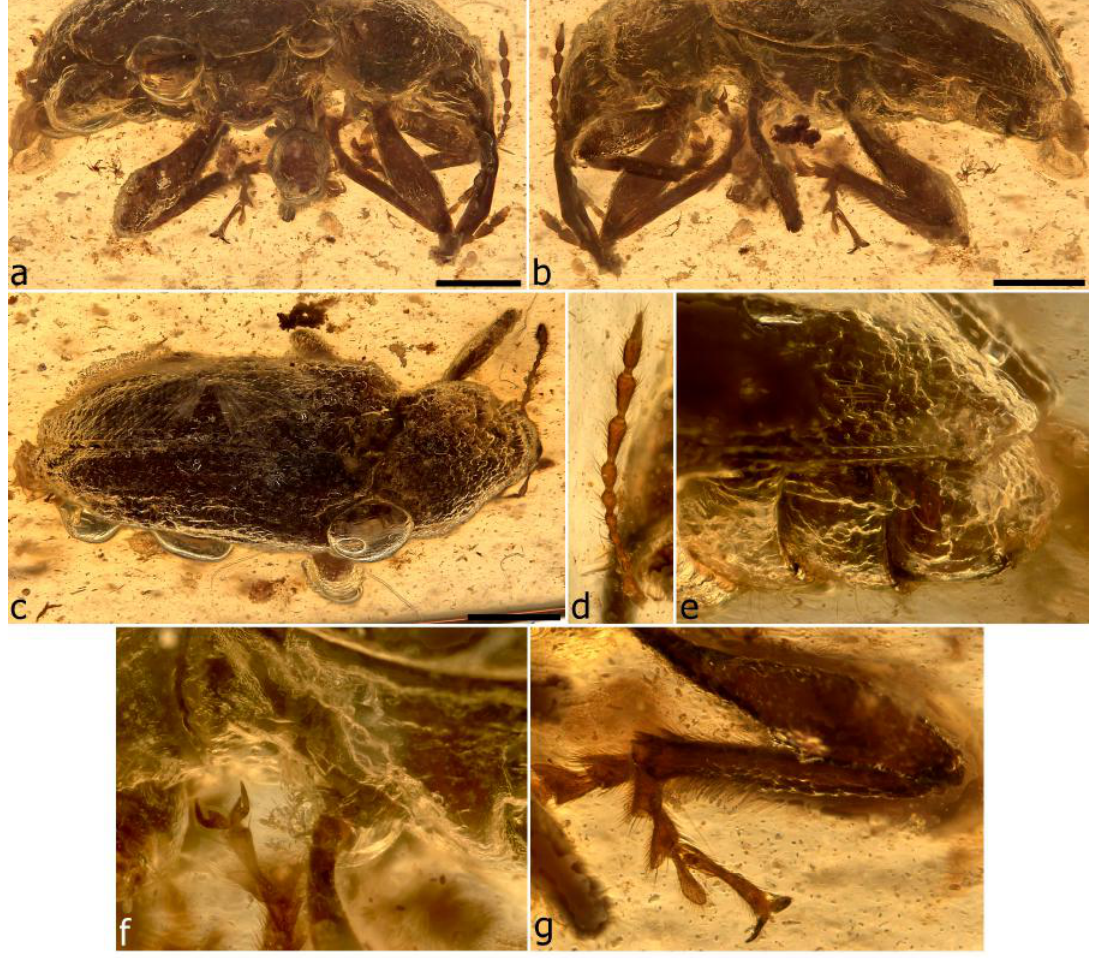
Figure 26. Acalyptopygus lingziae , holotype. Habitus, right ( a ); left ( b ); dorsal ( c ); antenna ( d ); elytral apices and ventrites 3–5 ( e ); thorax, left lateral ( f ); hindleg ( g ). Scale bars: 0.5 mm (a–c).